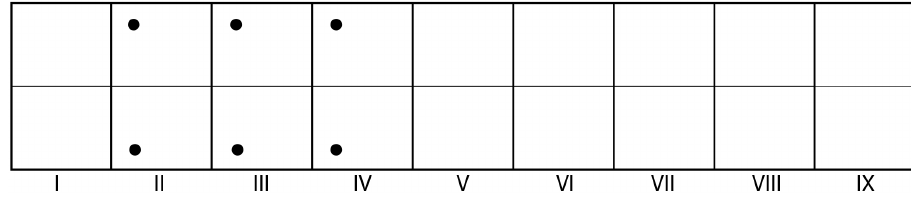
Figure 12. Oecetis mizrain , 5 th instar larva. Gill diagram indicating position of dorsal and ventral ab- dominal gills; lateral gills absent. Lateral line seemingly